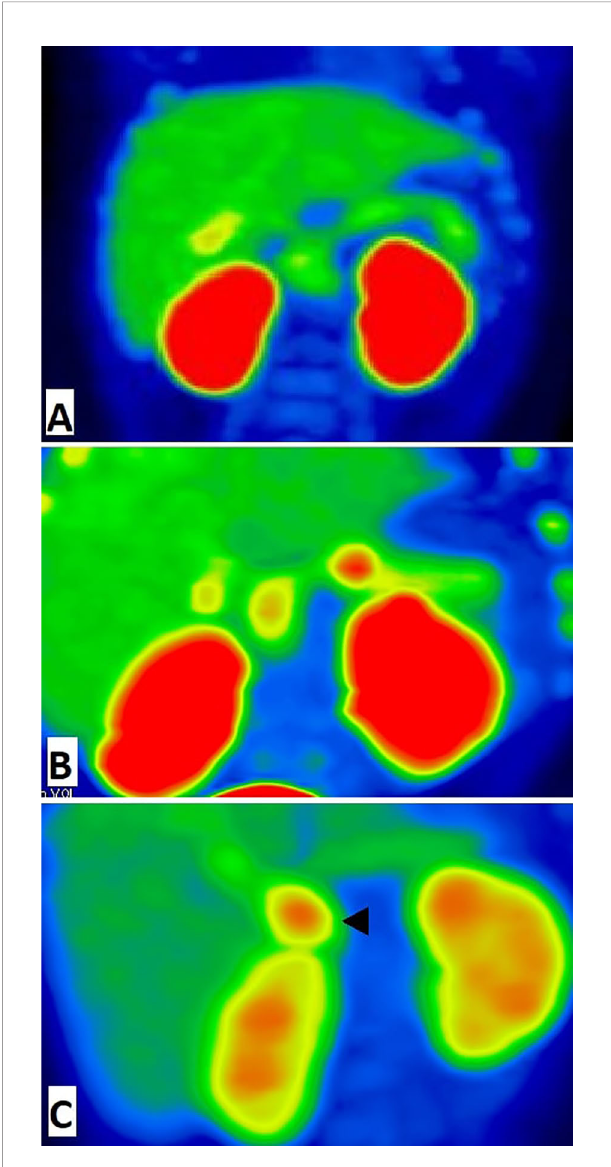
FIGURE 1 | 18 F- fl uoro-L-dihydroxyphenylalanine ( 18 F-DOPA)-positron emission tomography images (MIP) of pancreas. (A) The patient with diffuse congenital hyperinsulinism: homogenic 18F-DOPA uptake in pancreatic tissue. (B) The patient with focal form of congenital hyperinsulinism: focal intense 18 F-DOPA -PET accumulation in the pancreatic body and physiological 18 F-DOPA uptake in the pancreatic head. (C) False positive result of 18 F- fl uoro-L-dihydroxyphenylalanine (18F-DOPA)-positron emission tomography. Histologically proven atypical form imitates focal form of congenital hyperinsulinism with focus of adenomatous hyperplasia in the pancreatic head (arrowhead). In this case, we have found a disagreement between imaging (focal) and pathology